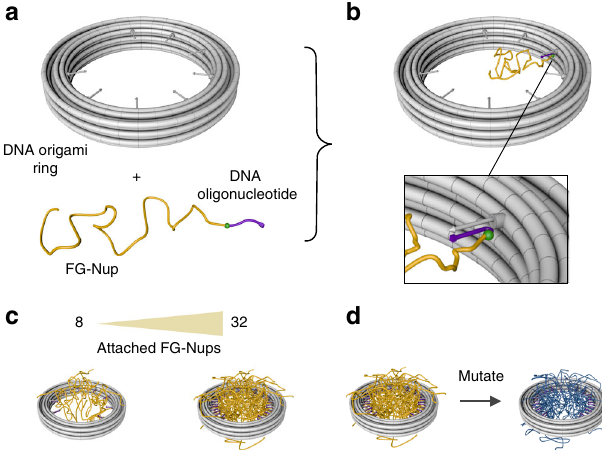
Fig. 1 Schematics of DNA origami ring with attached FG-Nups ( a ), DNA ring (see Supplementary Figure 1 for design details) and one NSP1 protein with a covalently attached oligonucleotide. b Ring with attached NSP1 protein. c DNA ring versions with 8 (left) and 32 (right) NSP1 proteins attached. d DNA ring with 32-NSP1 (left) and 32 mutated NSP1-S (right)